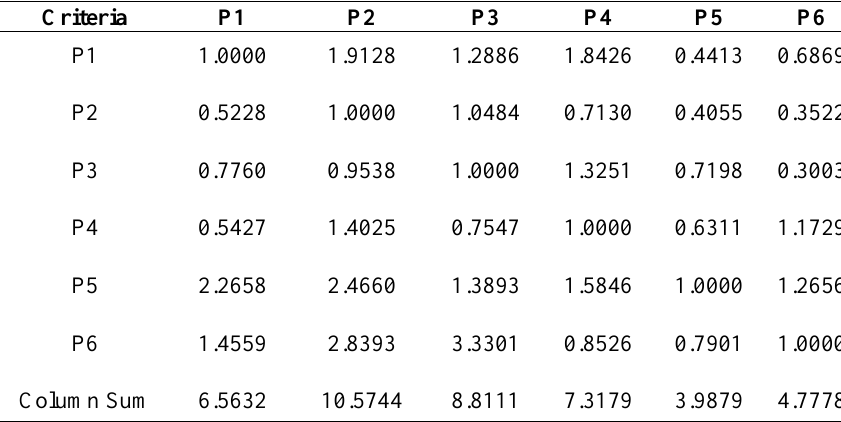
Table 3: Pairwise Comparison of Tax Avoidance and Compliance Dimension